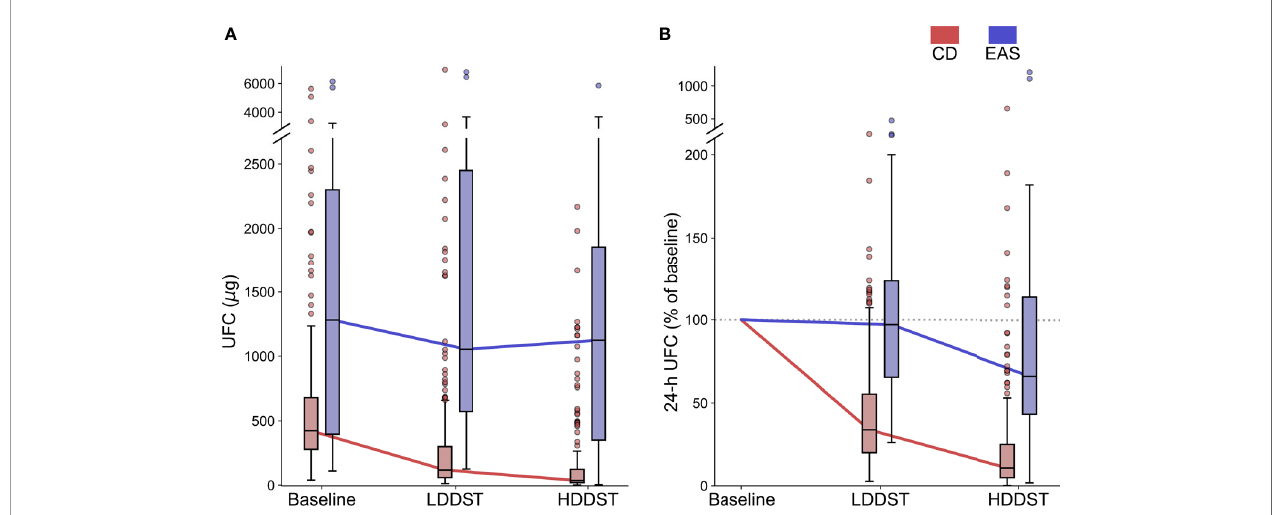
FIGURE 2 | Change of UFC during consecutive low-dose dexamethasone suppression test (LDDST) and high-dose dexamethasone suppression test (HDDST) for CD (red) and EAS (blue) patients. (A) 24-h UFC at baseline, after LDDST, and after HDDST. (B) The ratio of 24-h UFC after dexamethasone suppression test and baseline. Box: interquartile range (IQR). Horizontal line inside each box: median. Whisker: maximum and minimum within median ± 1.5 × IQR. Circle: outlier outside 1.5